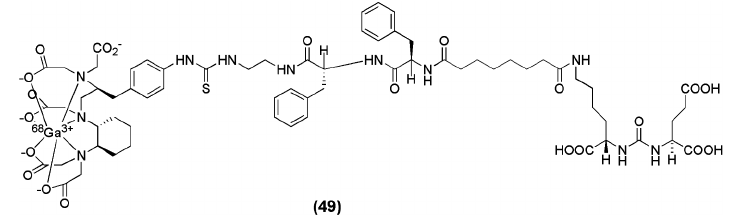
Figure 16. Chemical structure of 68 Ga-CHX-A ″ -DTPA-DUPA-Pep ( 49 ) [137].